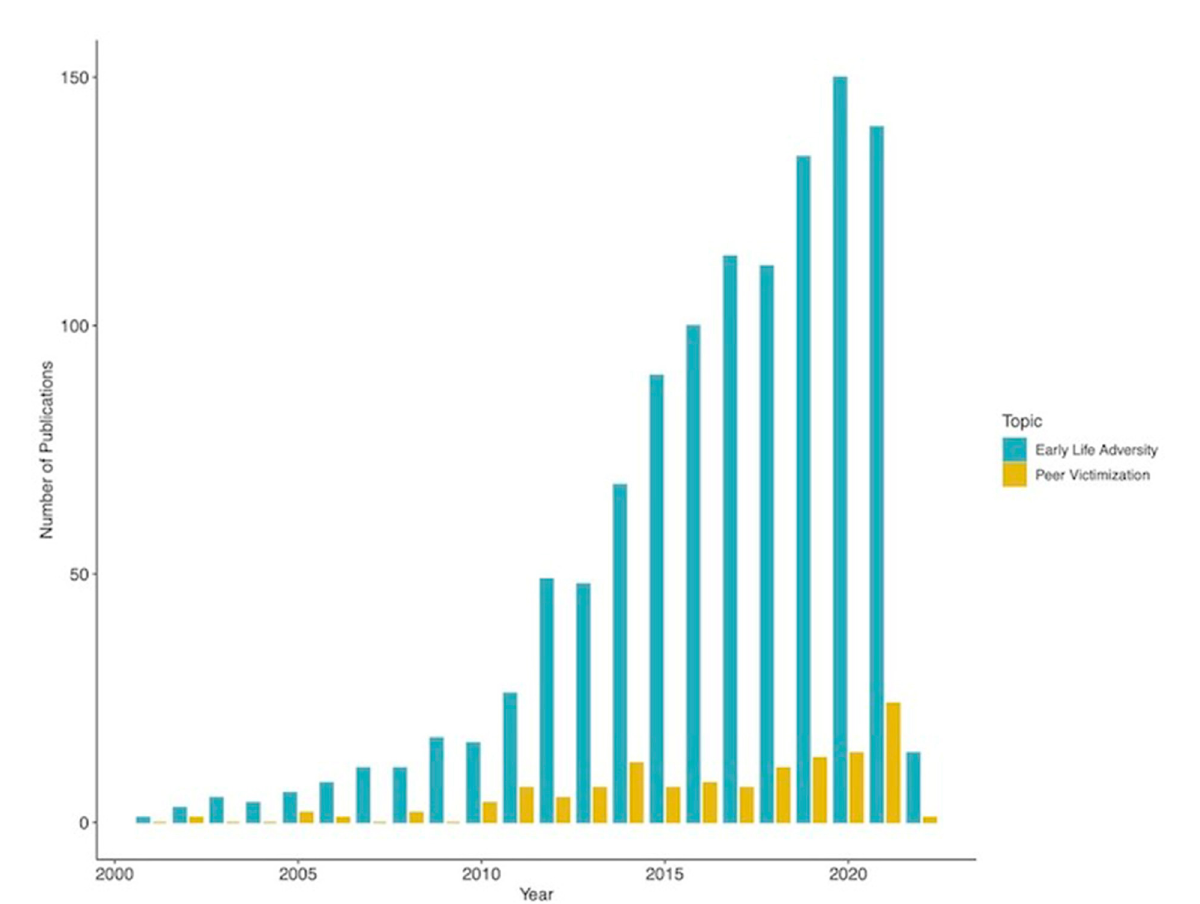
FIGURE1 Comparison of the number of publications on neural mechanisms of peer victimization. The figure shows the number of publications displayed in a search in pubmed with the words “Peer victimization” and “brain” relative to the number of publications on “Early Life Adversity” and “Brain”. Search data: 25 January